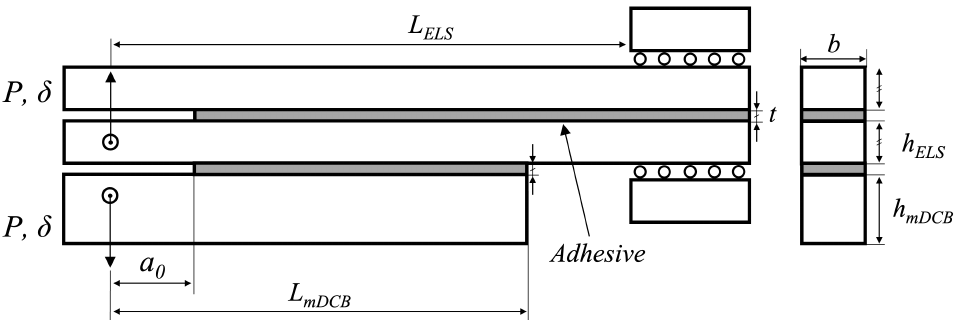
Figure 3. Schematic representation of the unified mode I and II fracture specimen and its associated testing